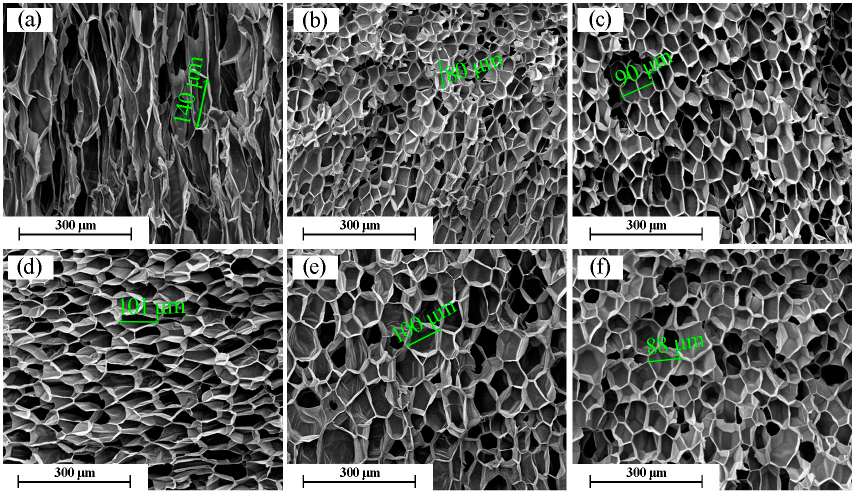
Figure 4. SEM micrographs for PP/TAIC (2 wt %) blend foams produced at 152 °C and 20 MPa and at different doses (kGy): ( a ) 0; ( b ) 10; ( c ) 20; ( d ) 30; ( e ) 40; and ( f ) 50.